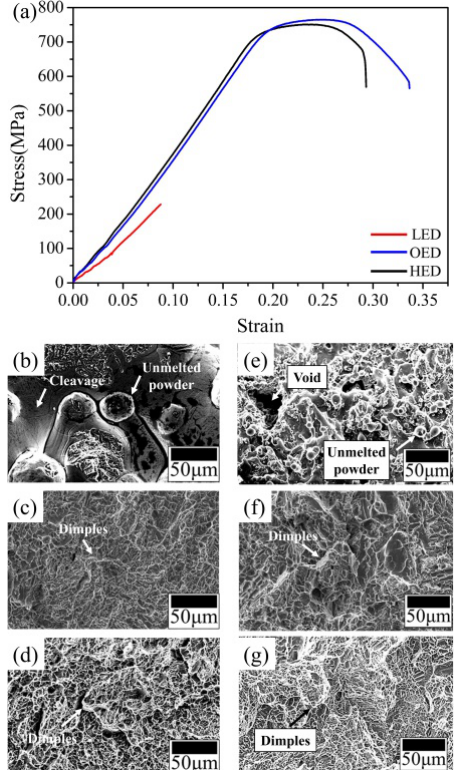
Figure 7. ( a ) Tensile stress-strain curves of gradient energy built samples. LED, OED and HED built samples were respectively denoted by red, blue and black curves. Representative fracture surface of tensile test of different density built in (b) to (d). ( b ) Unmelted powder and brittle cleavage in LED built sample, ( c ) and ( d ) both tensile fracture morphologies show fine and deeper dimples in HED and OED built samples. Representative fracture surface of impact test of different density built in ( e ) to (g). ( e ) Unmelted powders and voids were observed in LED samples, ( f ) and ( g ) both impact fracture morphologies show fine and deeper dimples in HED and OED built samples.